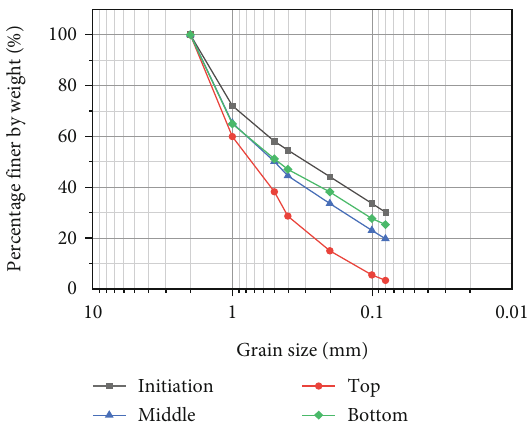
Figure 11: Test number 4 particle grading variation curves before and after seepage.